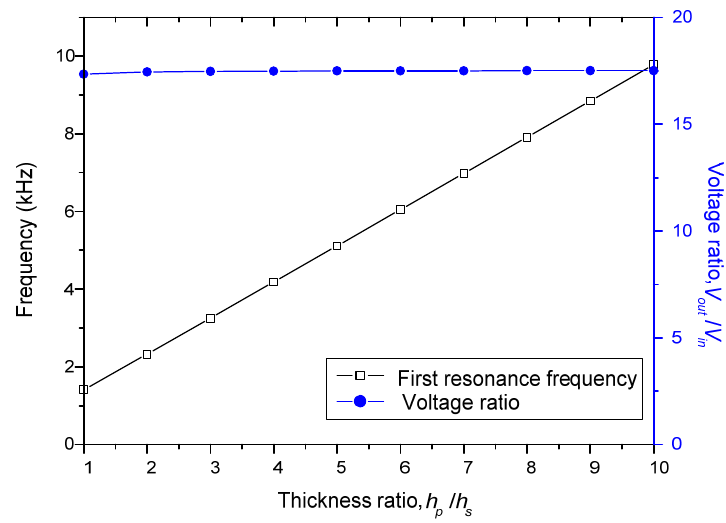
Figure 8. Effect of thickness ratio on voltage ratios and first resonance frequencies.